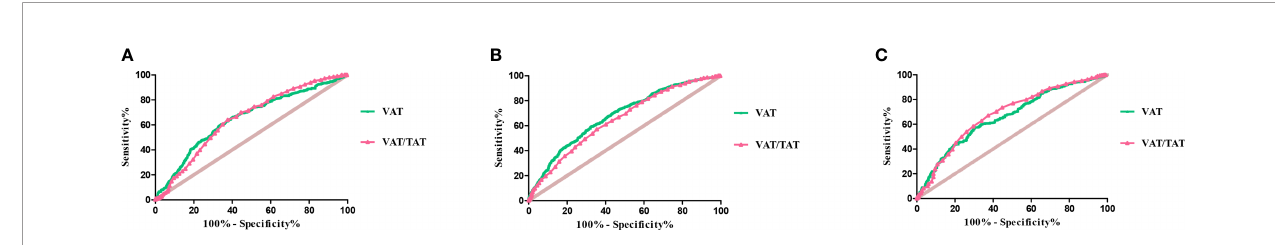
FIGURE 3 | ROC curves of VAT and VAT/TAT ratio for metabolically unhealthy in individuals with normal weight (A) , overweight (B) , and obese (C) .